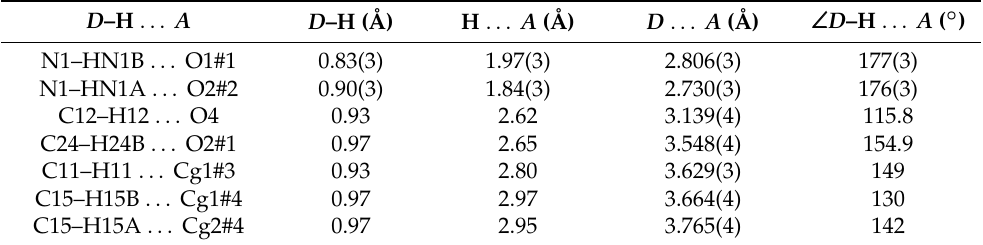
Figure 2. A view of the one-dimensional array of the title cation–anion compound built from N–H…O hydrogen bonds. Color keys are red O, orange P, dark blue N; the C atoms of cation and anion components are shown as green and blue colors, respectively. The carbon-bonded hydrogen atoms were omitted for the sake of clarity, and the hydrogen bonds are shown as dashed lines. Table 2. Hydrogen bond geometries (e.s.d.s are given in parentheses).